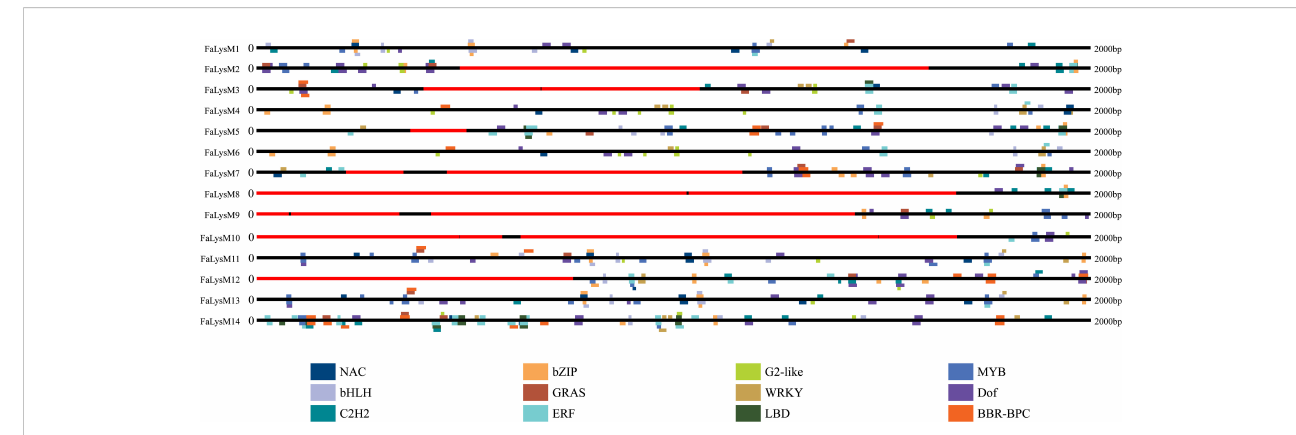
FIGURE 5 Distribution of transcription factor binding sites in the promoter of FaLysM genes. Twelve different colors represent twelve different transcription